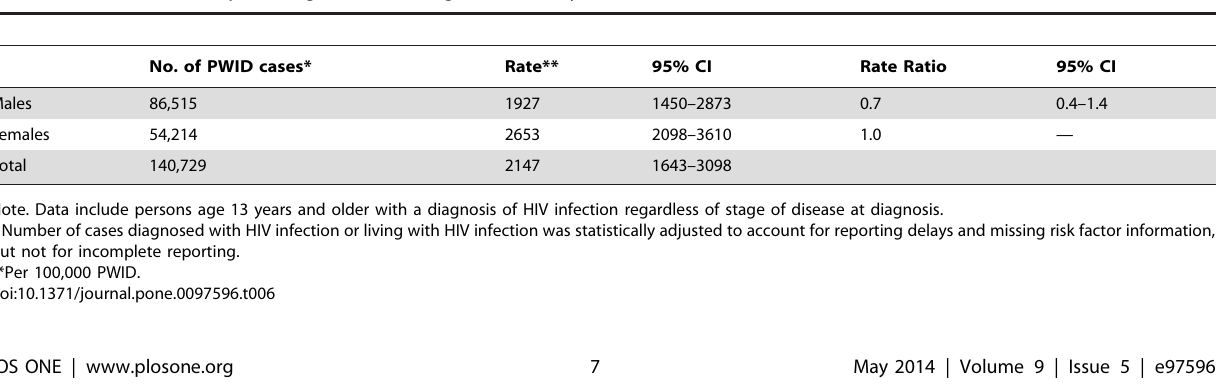
Table 6. Persons who inject drugs (PWID) living with HIV, by sex - United States, 2010.